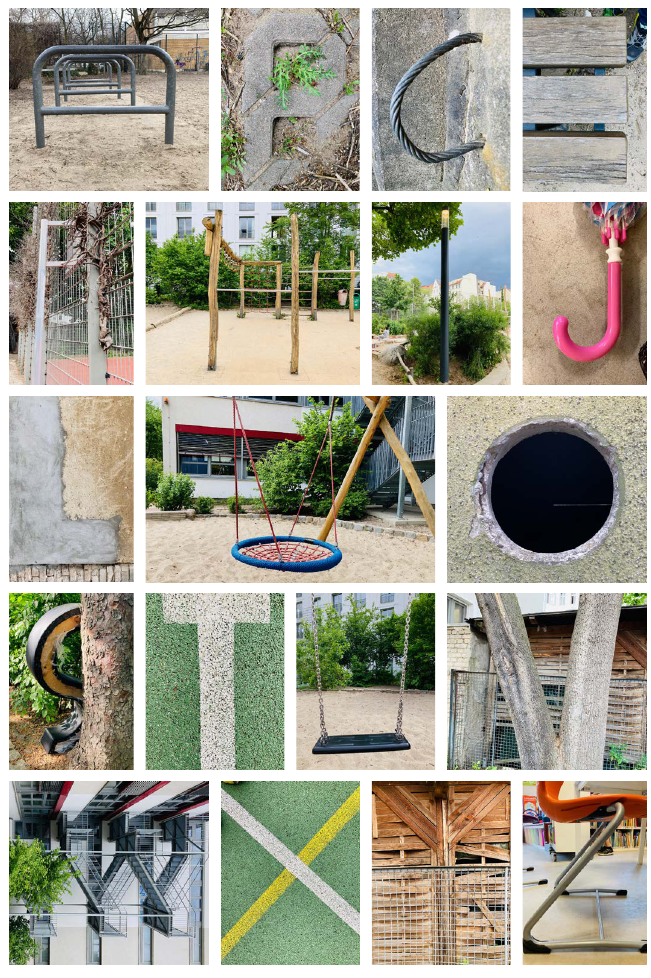
Fig. 7 Photo by Giulia